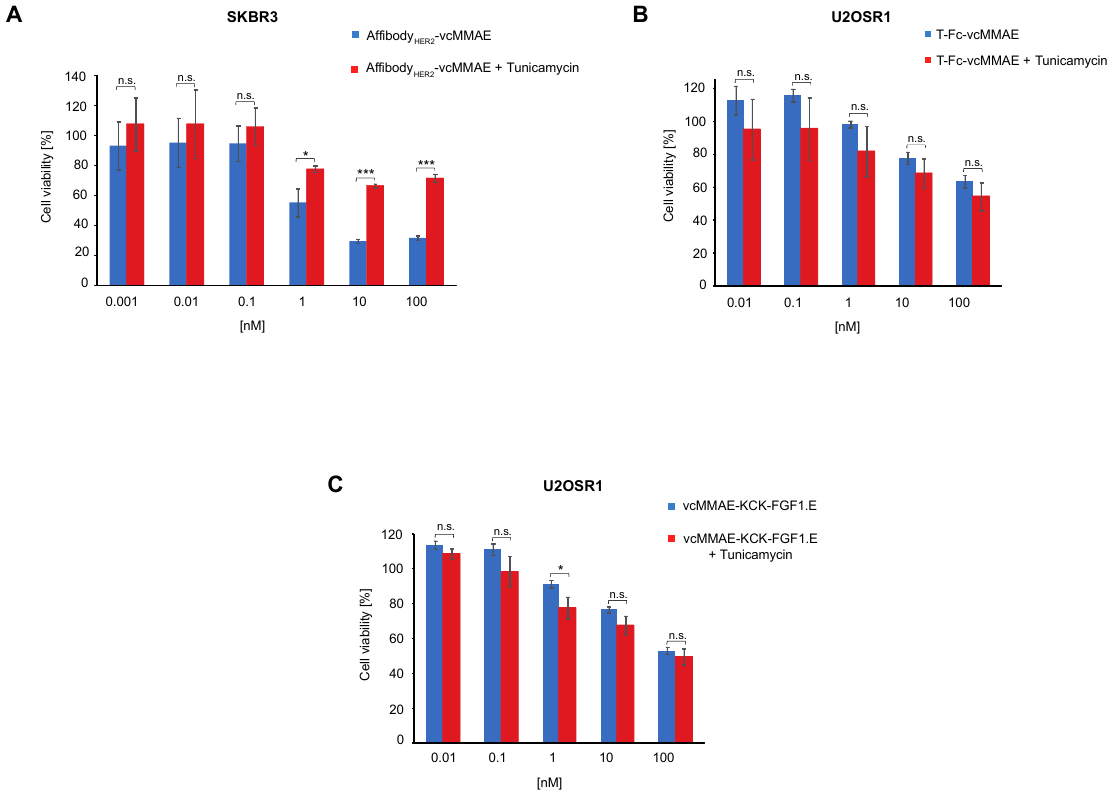
Figure 4. The role of cell surface N-glycosylation in the cytotoxicity of CCs. Cytotoxicity of CCs against FGFR1- or HER2-overproducing cells lacking N-glycosylation. The cytotoxic potential of Affibody HER2 -vcMMAE ( A ) was measured using SKBR3 cell line, and cytotoxic potential of T-Fc- vcMMAE ( B ) and vcMMAE-KCK-FGFE.1 ( C ) were measured using U2OSR1 cell line. Cells were incubated with tunicamycin 24 h before the experiment and treated with the indicated agents at various concentrations for 96 h, and cell viability was assessed in the Presto Blue assay. Results are mean values from three independent experiments ± SD. Statistical significance: * p < 0.05, *** p < 0.0001, n.s.—not significant.